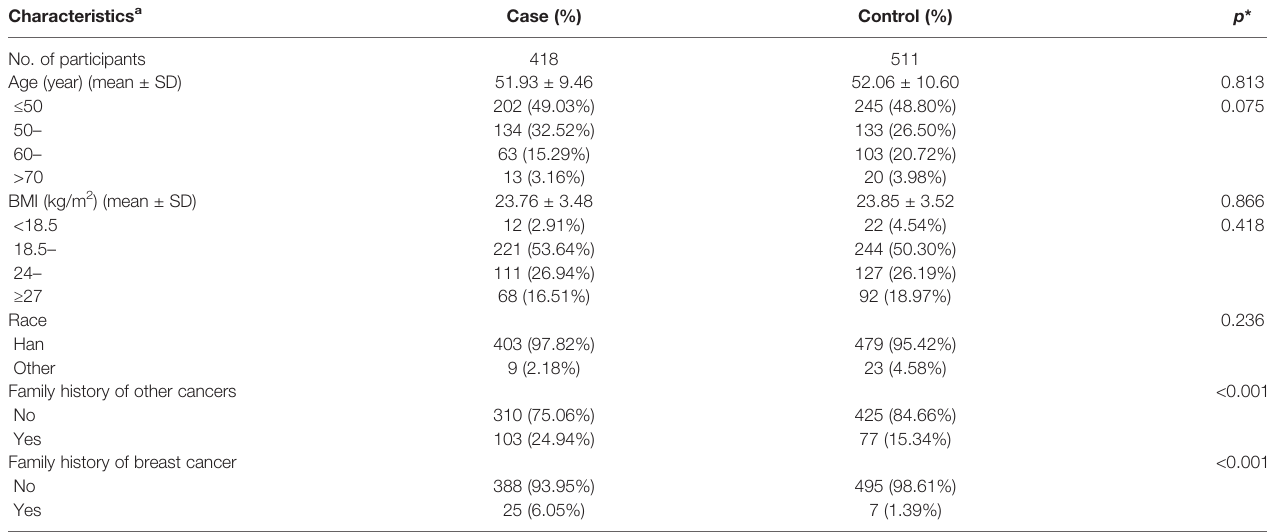
TABLE 2 | Demographic characteristics of BC patients and controls in case-control study. Characteristics